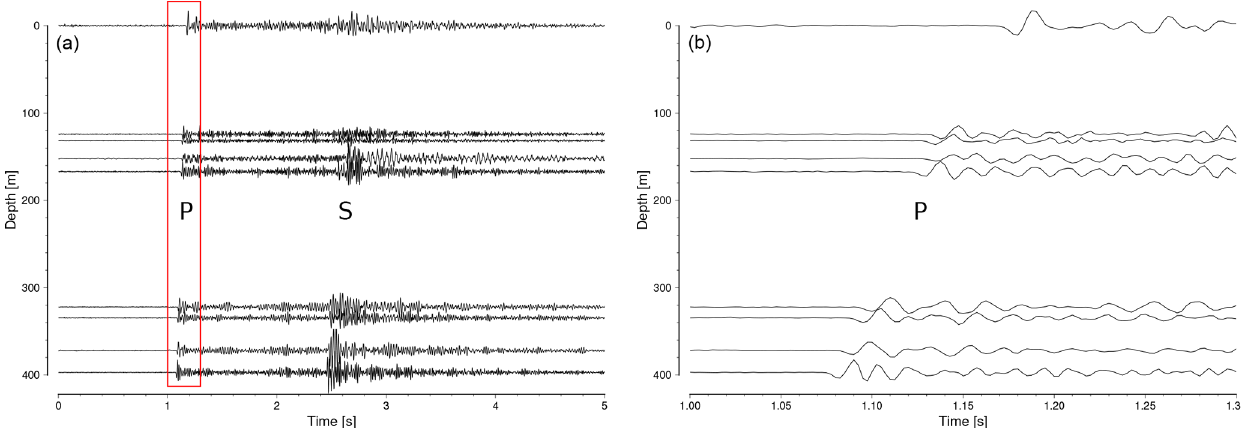
Figure 12. Example of microearthquake waveforms recorded with an 8-level borehole chain at S1 Landwüst (test installation before the deployment of the final 10-level chain) for the event on 23 January 2020, 22:21:11UTC at 8km depth, M L 0.1, at an epicentral distance of 11km (near Luby). Note the good signal-to-noise ratios (SNRs) of the recordings and their improvement with depth. The red box in panel (a) indicates the zoomed area in panel (b) .